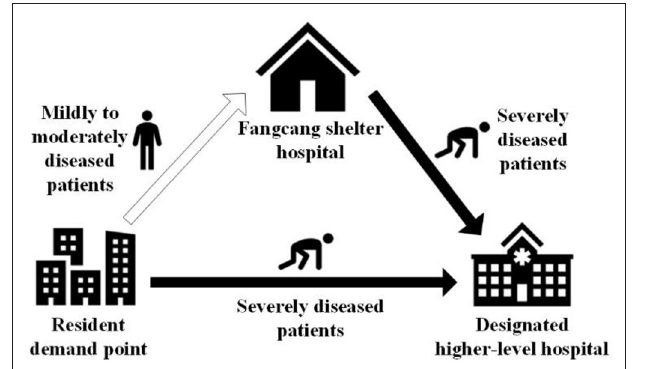
FIGURE 1 | Referral to and triage in a Fangcang shelter